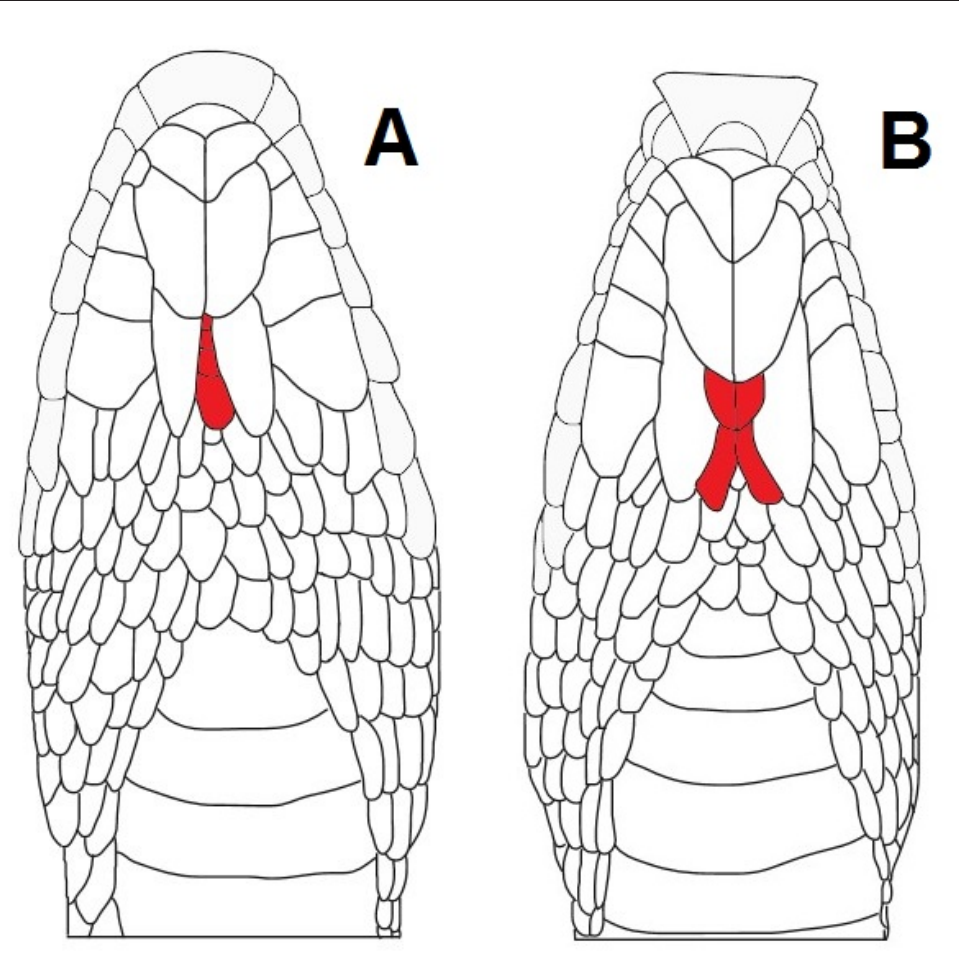
Fig. 15. A . Second pair of chinshields separated by one row of scales. B . Second pair of chinshields separated by two rows